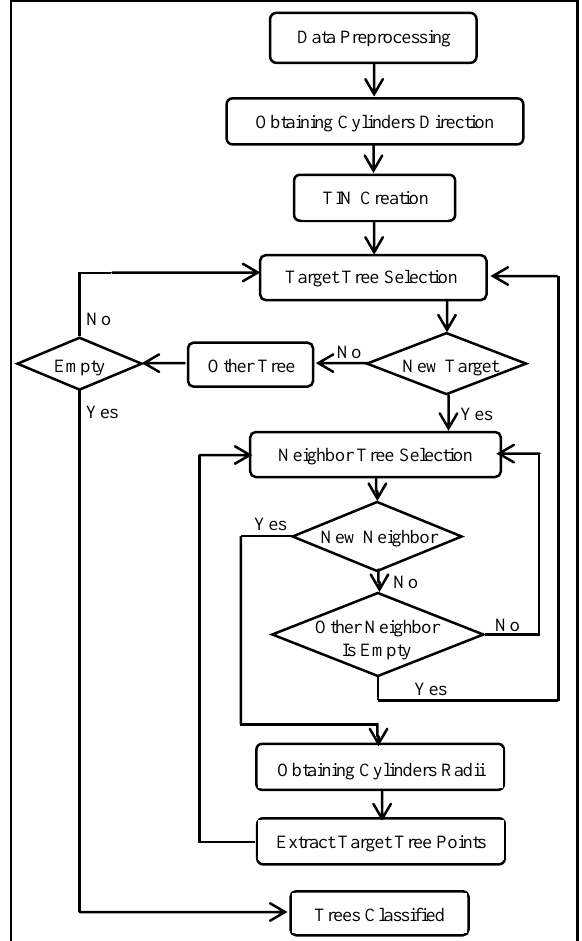
Figure 1. The flowchart of proposed